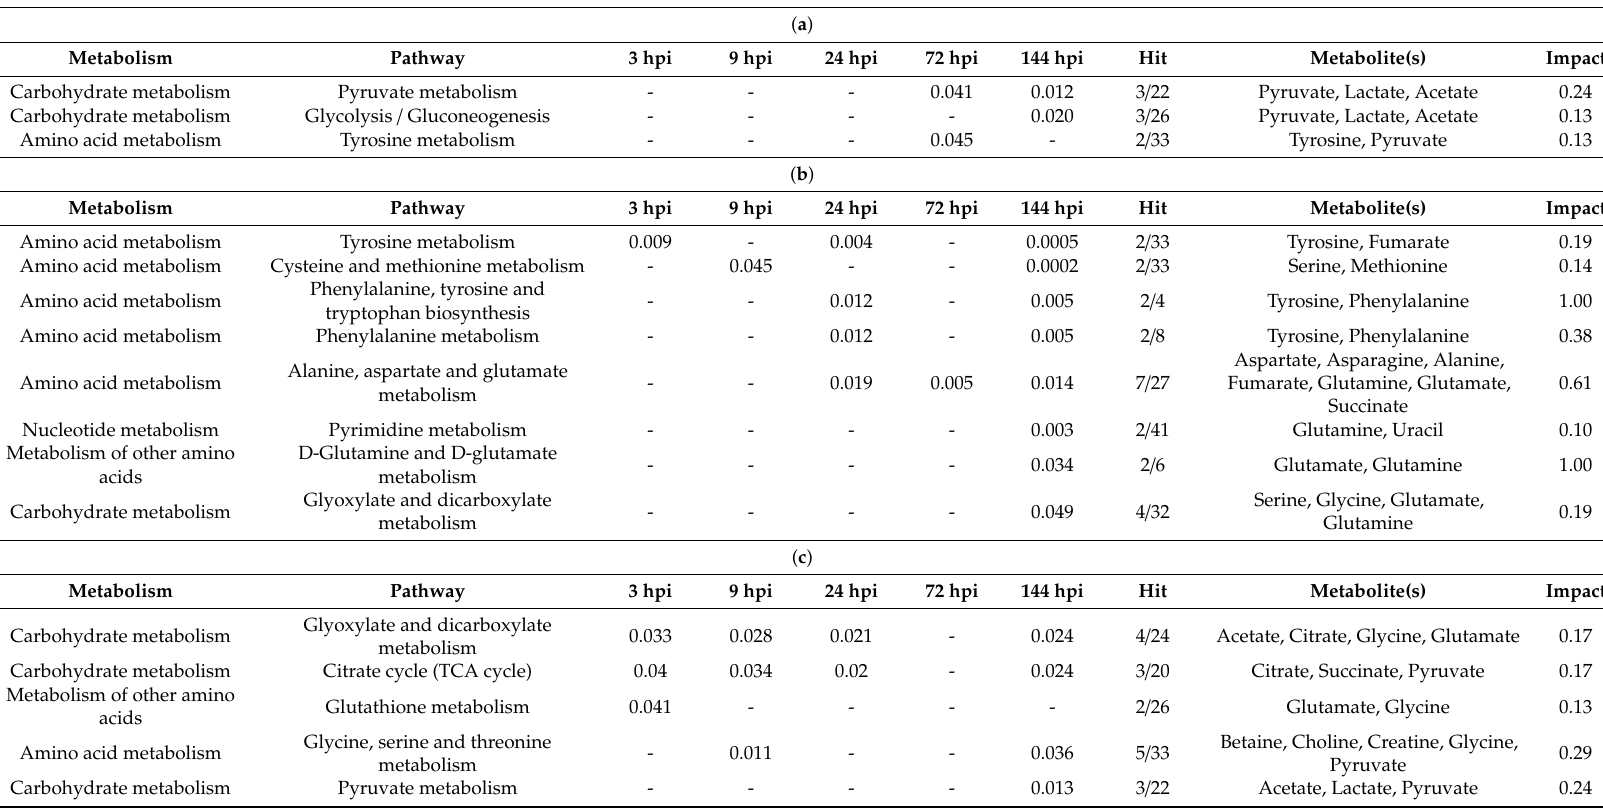
Table 1. Significant Kyoto Encyclopedia of Genes and Genomes (KEGG) metabolic pathways ( p < 0.05 and impact > 0.1) of the gills ( a ), hepatopancreas ( b ), and haemolymph ( c ) in L. vannamei infected with Vibrio harveyi